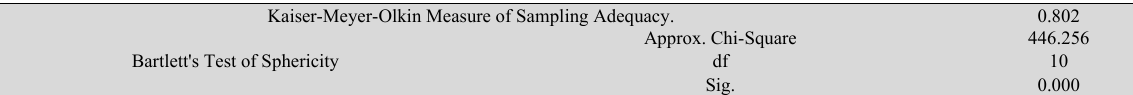
KMO coefficient and Bartlett's test of Satisfaction Kaiser-Meyer-Olkin Measure of Sampling Adequacy.